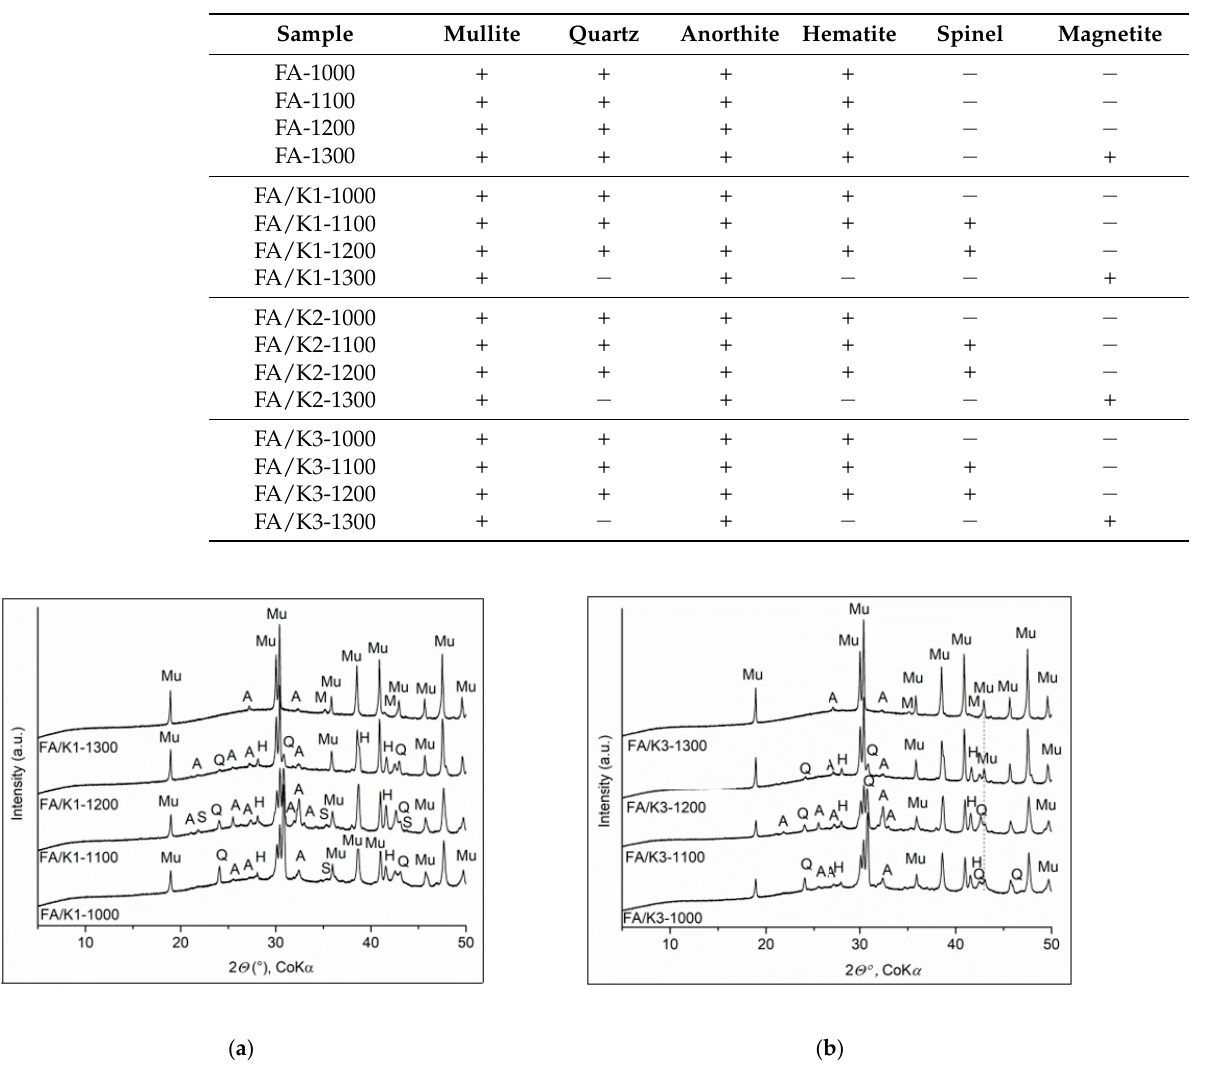
Table 3. Crystalline phases identified (+) and absent ( − ) in annealed FA and FA/K samples.